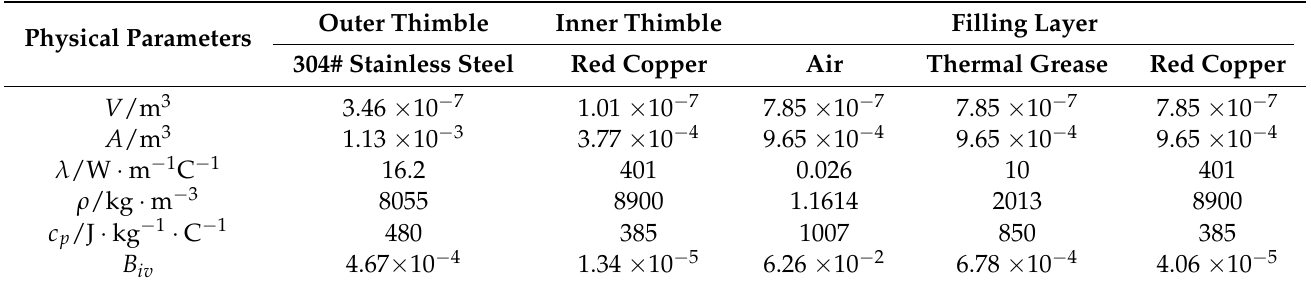
Table 1. Structural dimensions and thermophysical parameters of the double-thimble FBG temperature sensor. Physical